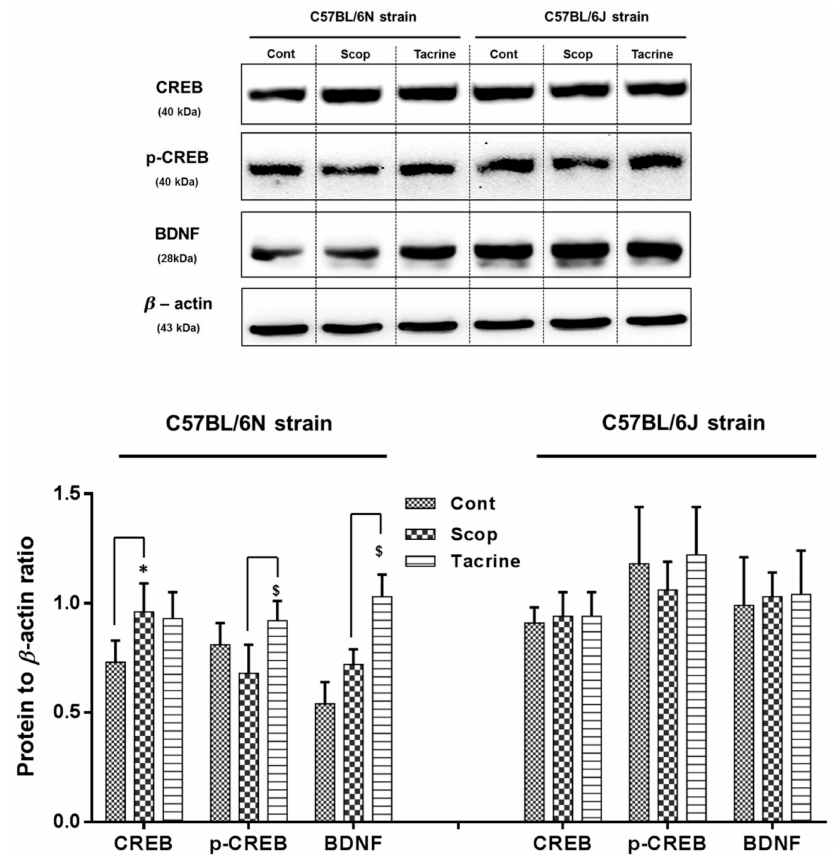
Figure 8. cAMP response-element binding protein (CREB)/brain-derived neurotrophic factor (BDNF) protein markers expression in the hippocampus of scopolamine-induced amnesic models—C57BL/6N and C57BL/6J substrains: Western blotting of CREB, p-CREB, and BDNF protein expression and its quantification relative to β -actin expression. Data are expressed as mean ± SD ( n = 3). One-way ANOVA-Tukey’s multiple comparison test was performed where, * p < 0.05 scopolamine compared with the control group; $ p < 0.05 tacrine compared with scopolamine-treated